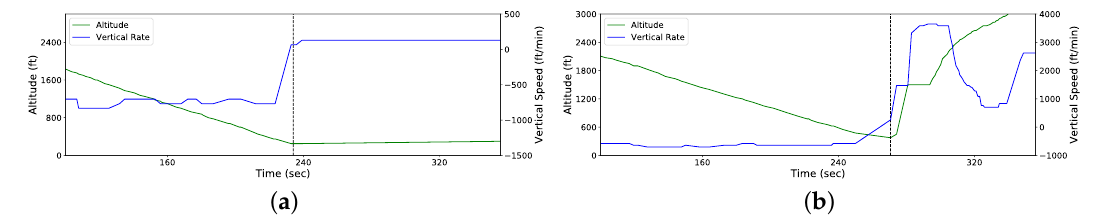
Figure 2. Example altitude and vertical speed profiles for two flights flagged by only some of the methods tested. The dashed vertical line indicates where methods detected a go-around ( a ) Incorrectly flagged as a go-around by methods 2 and 3, due to the aircraft reporting higher altitudes post-landing than during descent. ( b ) Correctly flagged as a go-around by methods 1, 3 and 5, but not 2 or